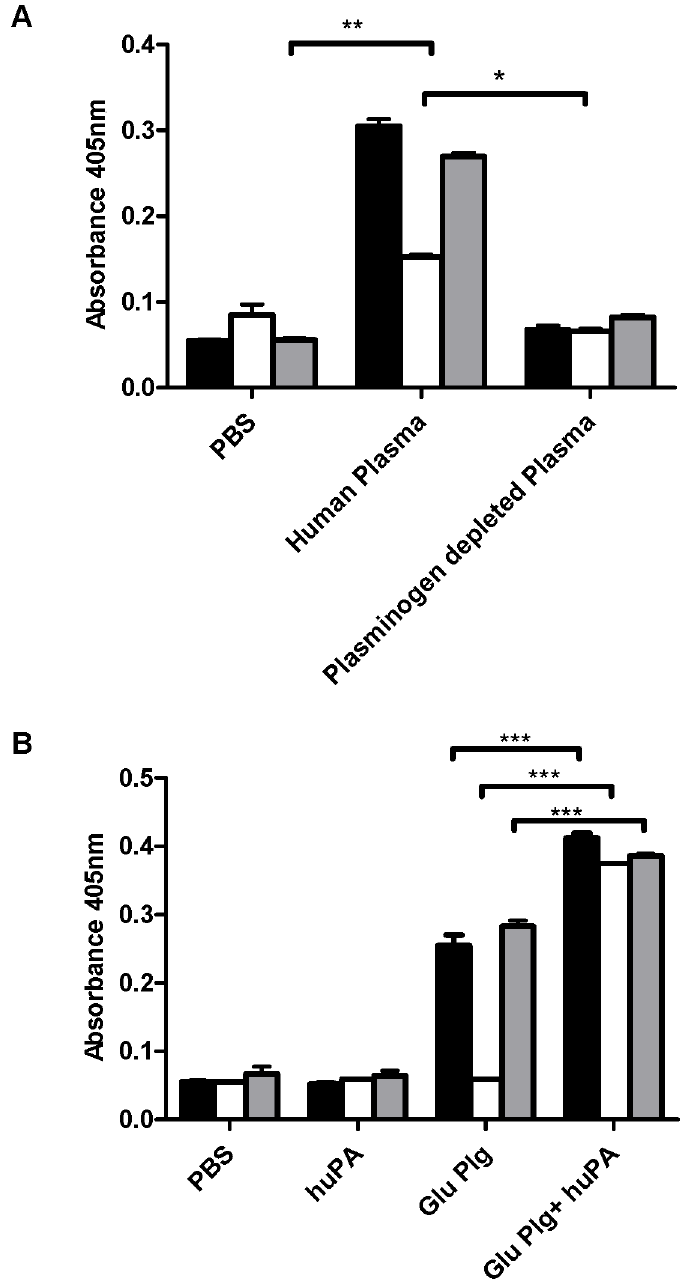
Figure 1. Cell surface plasmin acquisition in the absence of streptokinase. A GAS strains 5448 (black fill), 5448 D ska (no fill) and 5448* (grey fill) readily acquire cell surface plasmin activity during a 3 h incubation in human plasma, but not plasminogen-depleted plasma or PBS. B In the absence of streptokinase, uPA can mediate cell surface plasmin acquisition by GAS in vitro . Data is representative of 2 independent experiments. Error bars indicate SEM ( n =3), asterisks indicate statistical significance as determined by unpaired two-tailed students t-test P , 0.005 (**), P , 0.001 (***).